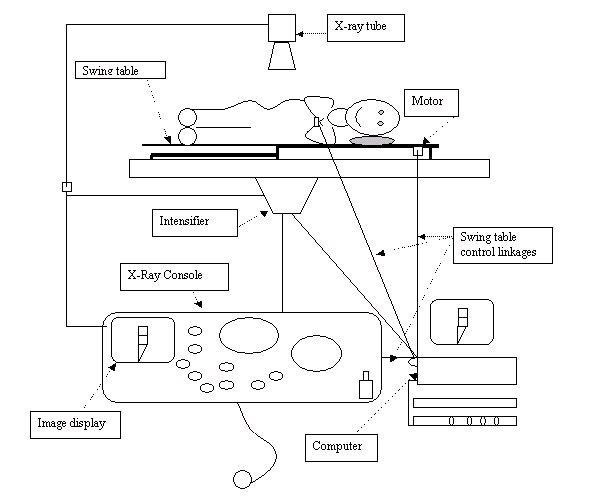
The OSMIA image acquisition system.